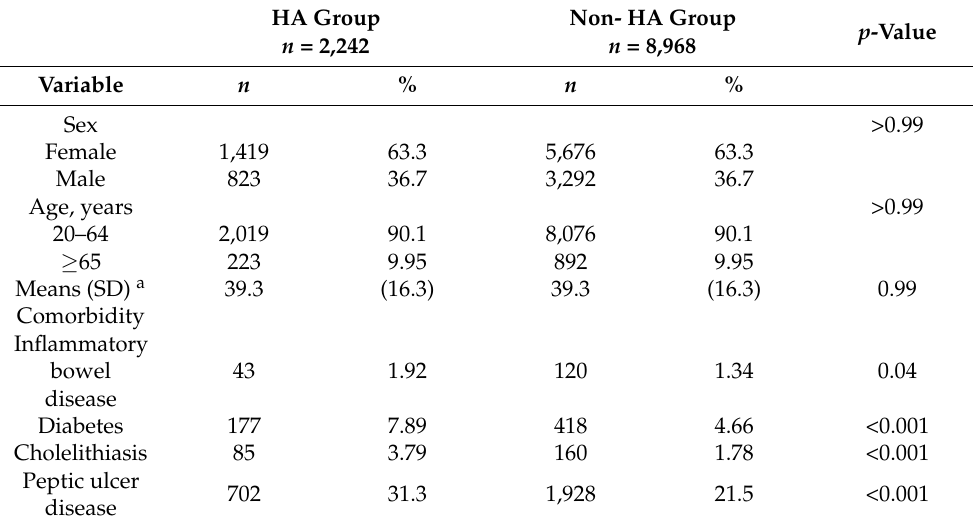
Table 1. Demographic factors and comorbidity of study participants according to hemolytic anemia